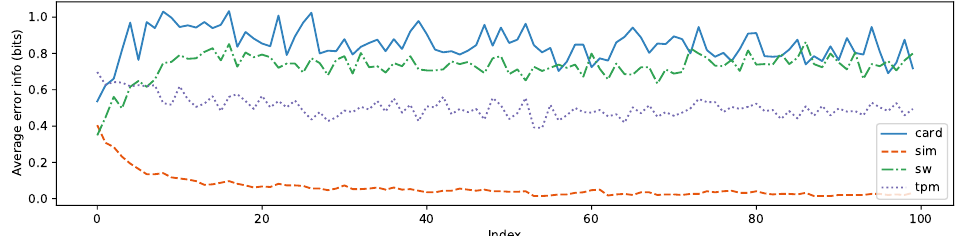
Figure 16: Average amount of erroneous information per index with d = 100, when the geometric bounds are used with the four datasets. Here, average erroneous information means the average of error probability multiplied with the error depth (e.g. by how many bits was the bound overstated) at each